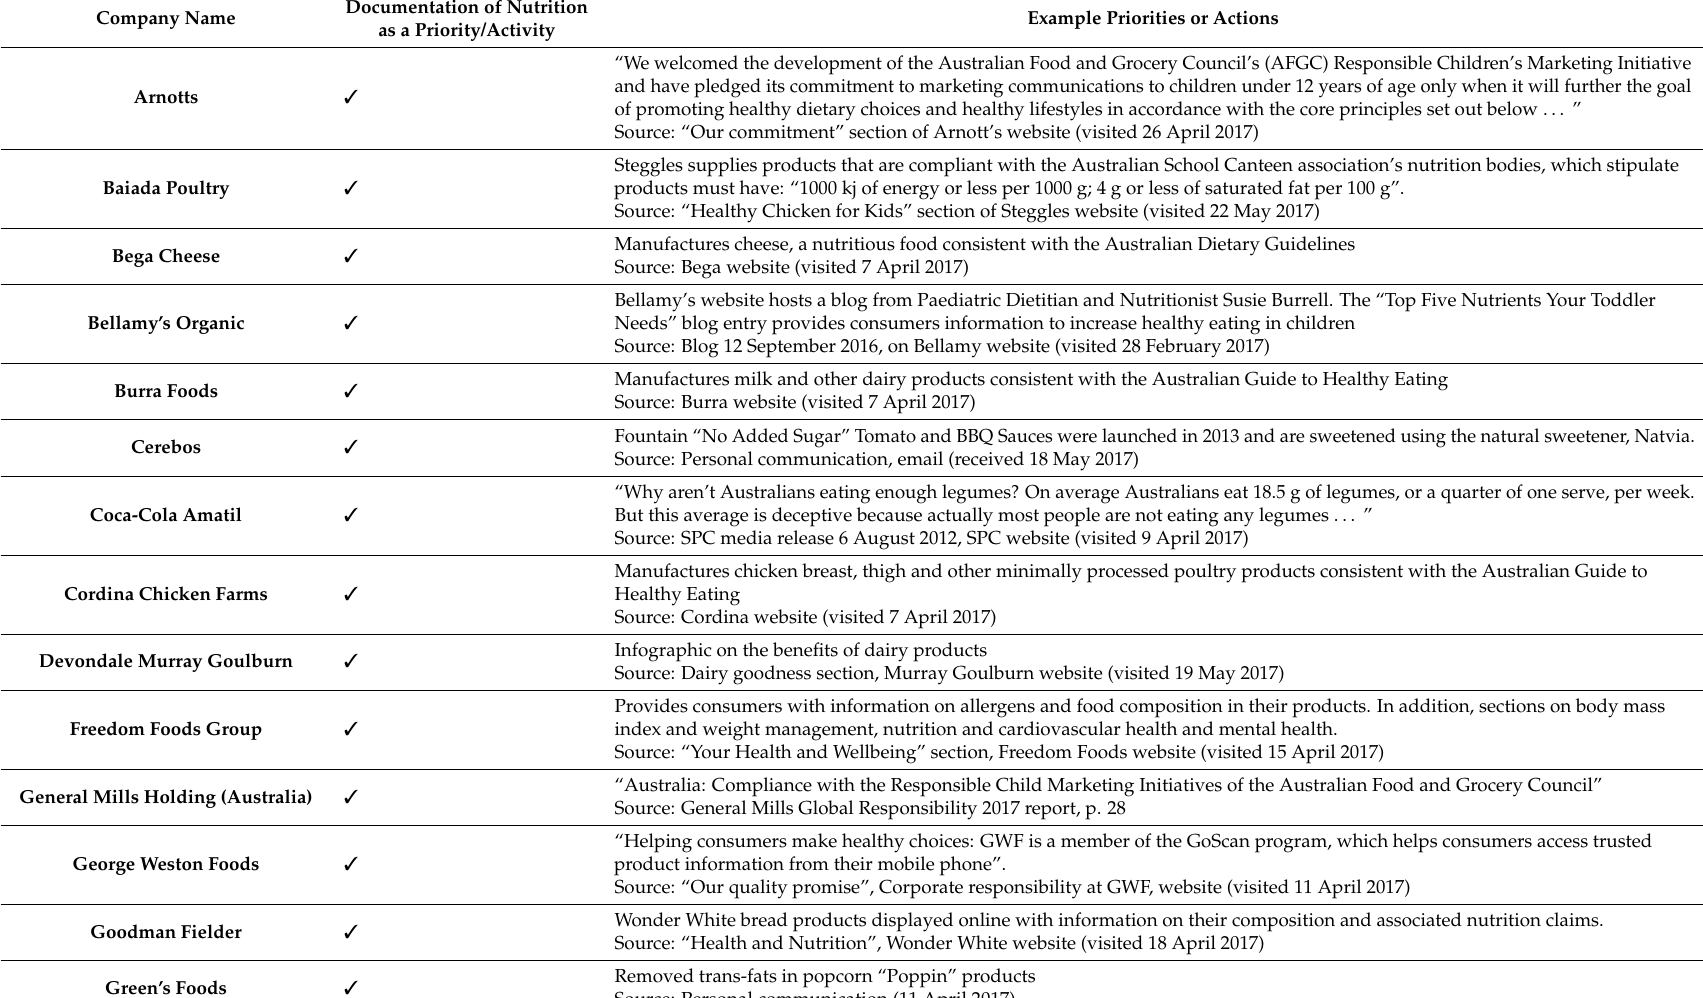
Table 4. Priorities and actions publically reported by Australian